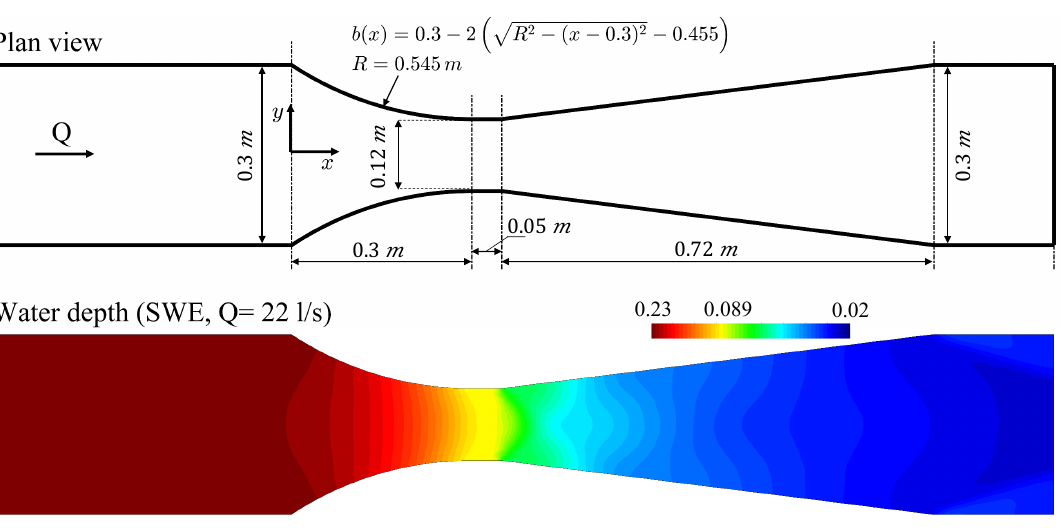
Figure 9. Model validation: transcritical flow in a Khafagi flume. Schematic description of the flume geometry, according to the experiments of [24], and steady-state water depth for a flow discharge Q = 22